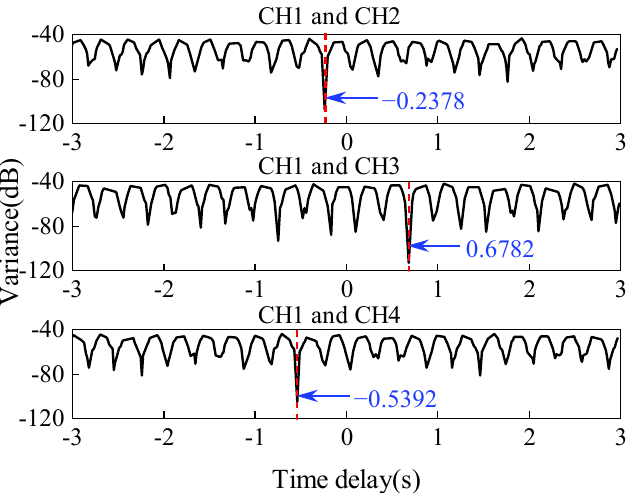
Figure 7. Relationships between delay and variance of the candidate pool time lags.